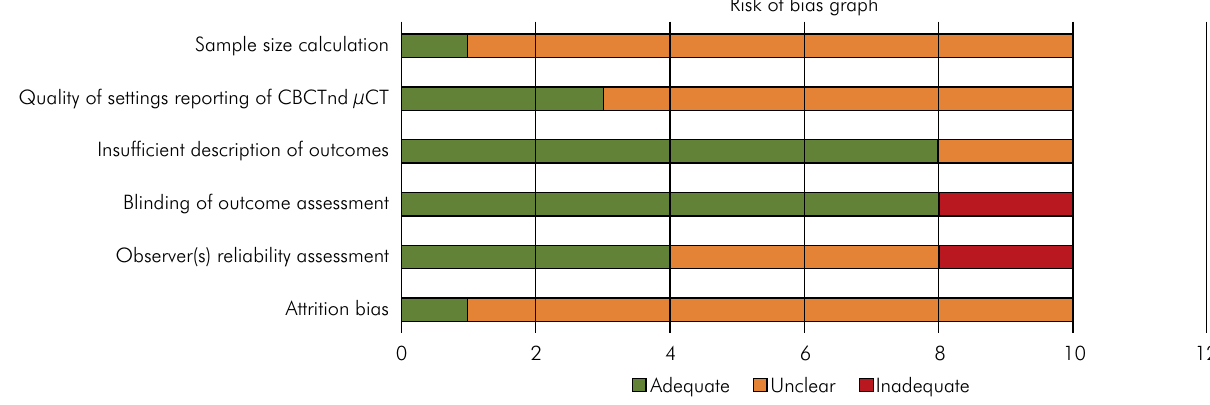
Figure 3. Risk of bias graph: Reviewers’ judgements about each risk of bias item presented across all included studies.